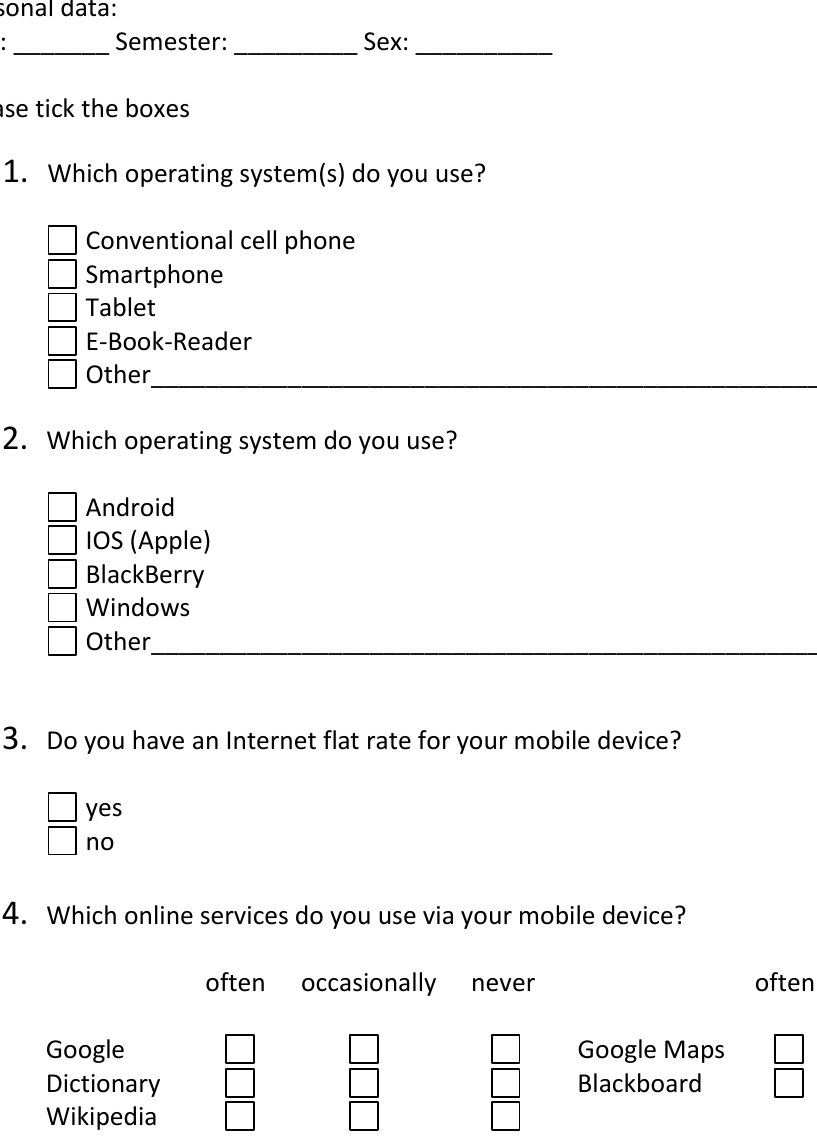
Fig. 1. Questionnaire to assess the use of mobile devices by German veterinary students Personal